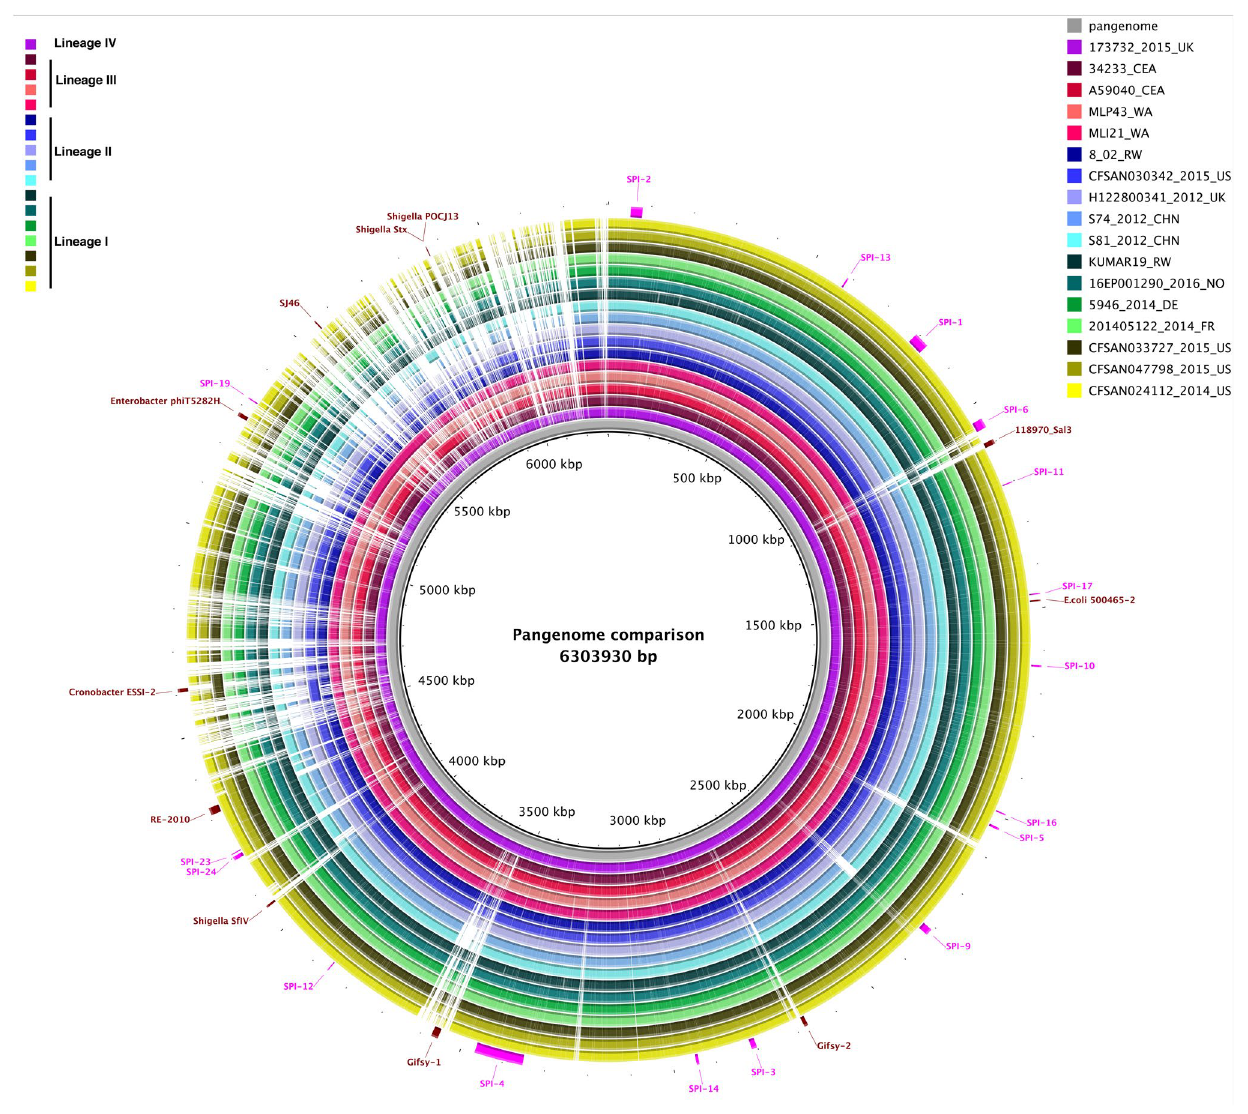
Figure 3. Genome comparison of selected lineage specific isolates against the pangenome generated from 197 S . Enteritidis genomes using Roary v3.12.0. Legend showing color gradient for % similarity. The prophage regions and Salmonella pathogenicity islands (SPIs) from the pangenome are annotated in Artemis and marked in brown and pink,